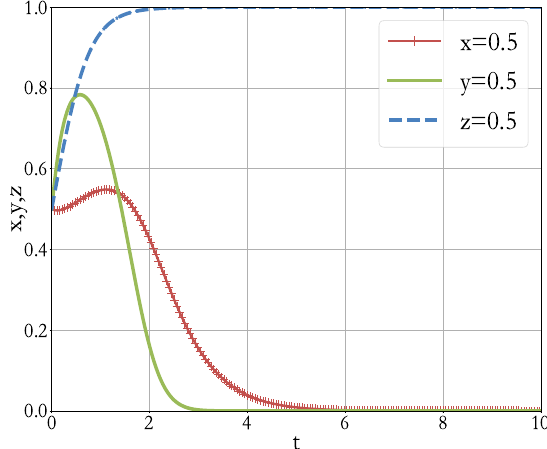
Figure 5. Initial equilibrium point E p 2 (0,0,1).